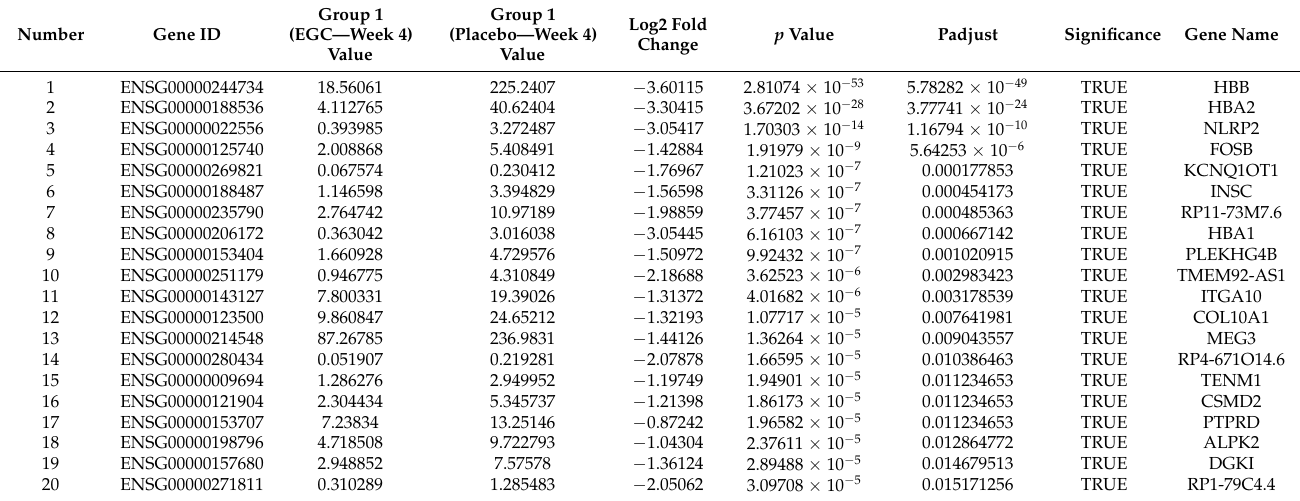
Table 6. Table of differentially expressed downregulated genes for Group 1 at week 4. The table gives an example of the first 20 most differentially expressed genes which were downregulated with EGCG compared to placebo in Group 1 at week 4. The yellow highlighted cells represent the hemoglobin genes that were downregulated with EGCG.